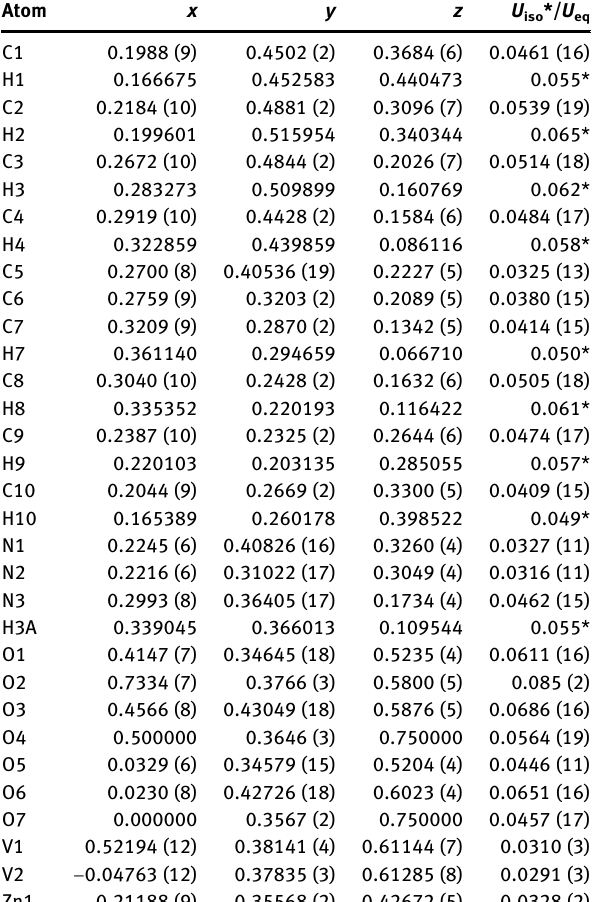
Table  : Fractional atomic coordinates and isotropic or equivalent isotropic displacement parameters (Å 